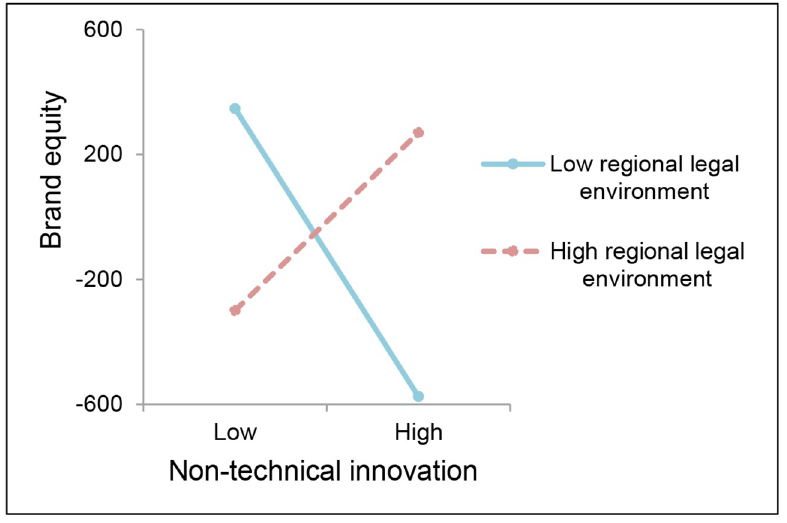
Fig 3. The moderating effects of H 4b